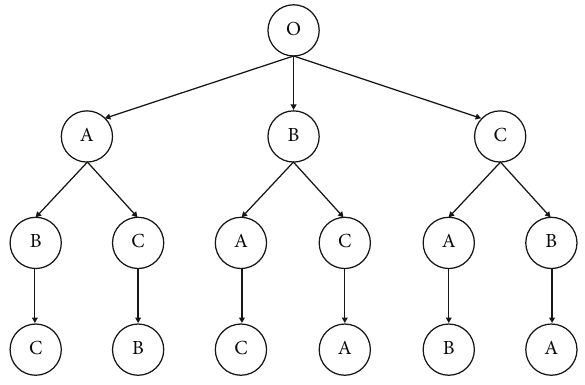
Figure 10: Path planning decision tree.